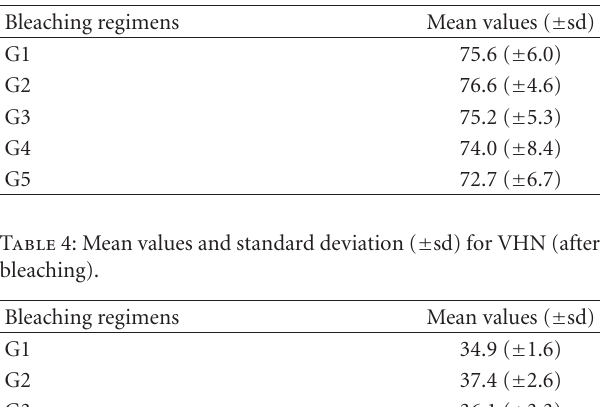
Figure 1: Mean Δ E values for all Groups (G1: control; G2: Hydro- gen peroxide 7%; G3: Hydrogen peroxide 35%; G4: Carbamide peroxide 10%; G5: Carbamide peroxide 35%). Table 3: Mean values and standard deviation ( ± sd) for VHN (baseline).